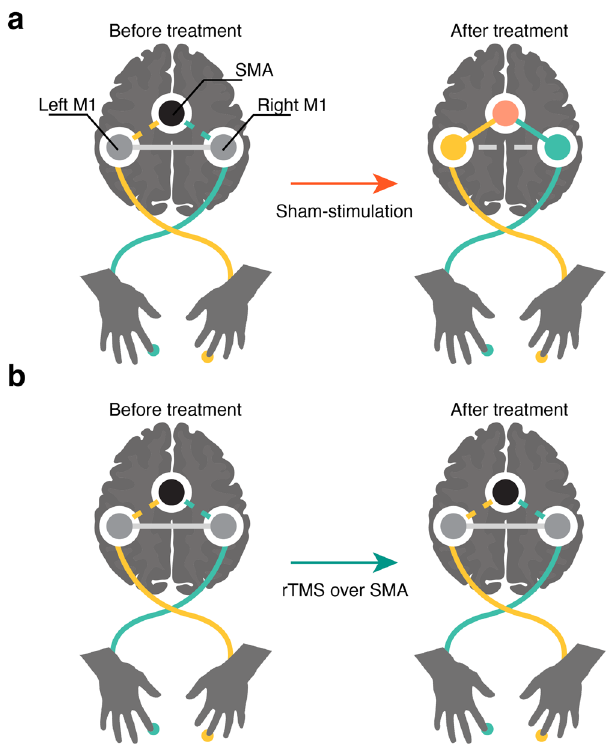
Fig. 5 Schematic of interpretations of experiment results. a Changes in activity patterns of the motor network by performance improvement. The interaction term of SMA activities and M1-M1 PLV re fl ect behavioral performance since the modulatory effects of SMA on M1 are weaker when M1-M1 PLV is low during the pre-movement period. b Changes in the activity patterns of the motor network after rTMS treatment. The interaction term of SMA activities and M1-M1 PLV do not re fl ect the performance since SMA activities do not modulate M1-M1 PLV due to SMA activity